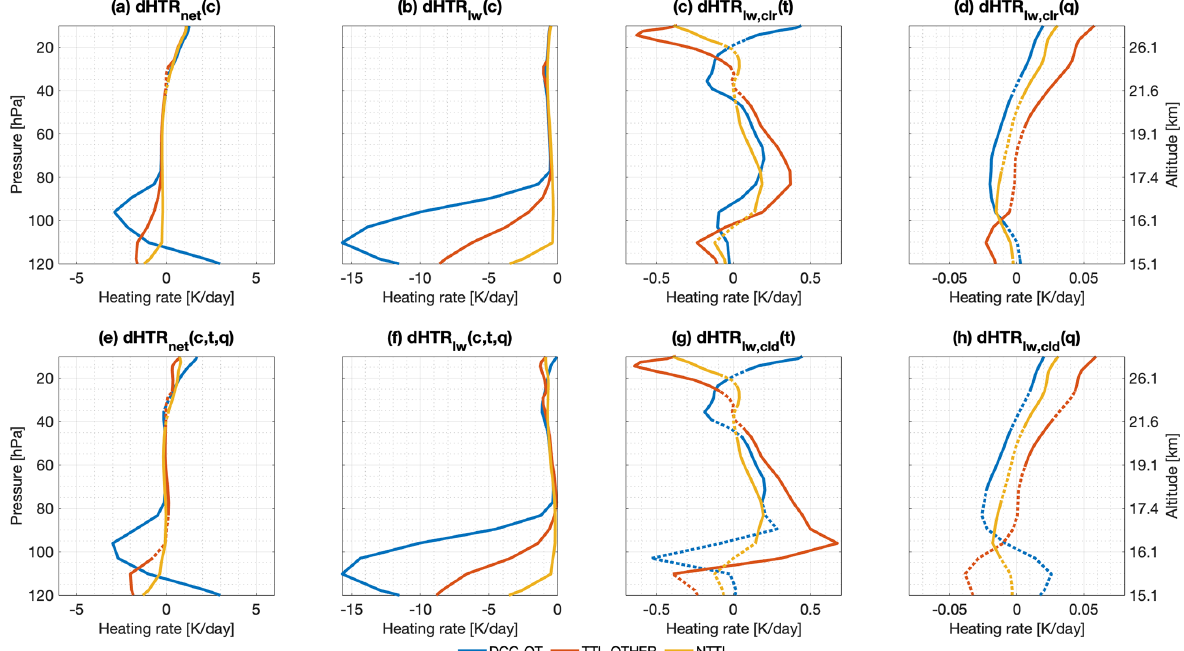
Figure 13. The radiative heating effects of cloud, temperature, and water vapor. (a) The net effects of cloud, dHTR net (c) . (b) The longwave effects of cloud, dHTR lw (c) . (c) The longwave effects of temperature for clear-sky conditions, dHTR lw , clr (t) . (d) The longwave effects of water vapor for clear-sky conditions, dHTR lw , clr (q) . (e) The net effects of cloud, temperature, and water vapor, collectively, dHTR net (c,t,q) . (f) The longwave effects of cloud, temperature, and water vapor, collectively, dHTR lw (c,t,q) . (g) The longwave effects of temperature for cloudy-sky conditions, dHTR lw , cld (t) . (h) The longwave effects of water vapor for cloudy-sky conditions, dHTR lw , cld (q)